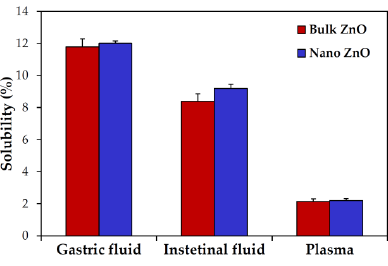
Figure 3. Ex vivo dissolution properties of ZnOs in rat-extracted gastrointestinal fluids and plasma after incubation for 30 min. No significant differences between particle sizes were found ( p > 0.05).